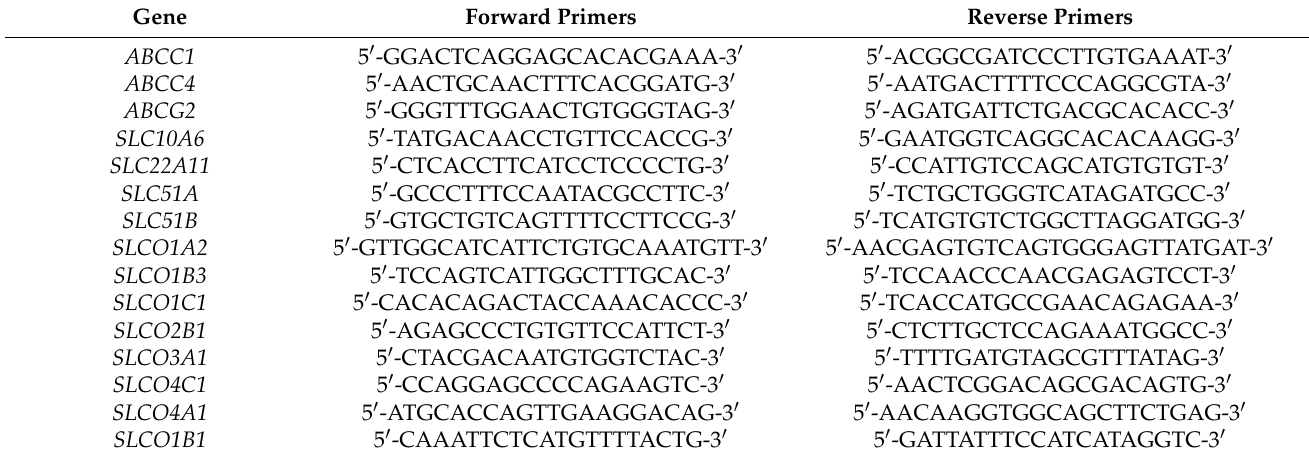
Table 4. Sequences of the primers used for amplification of genes of